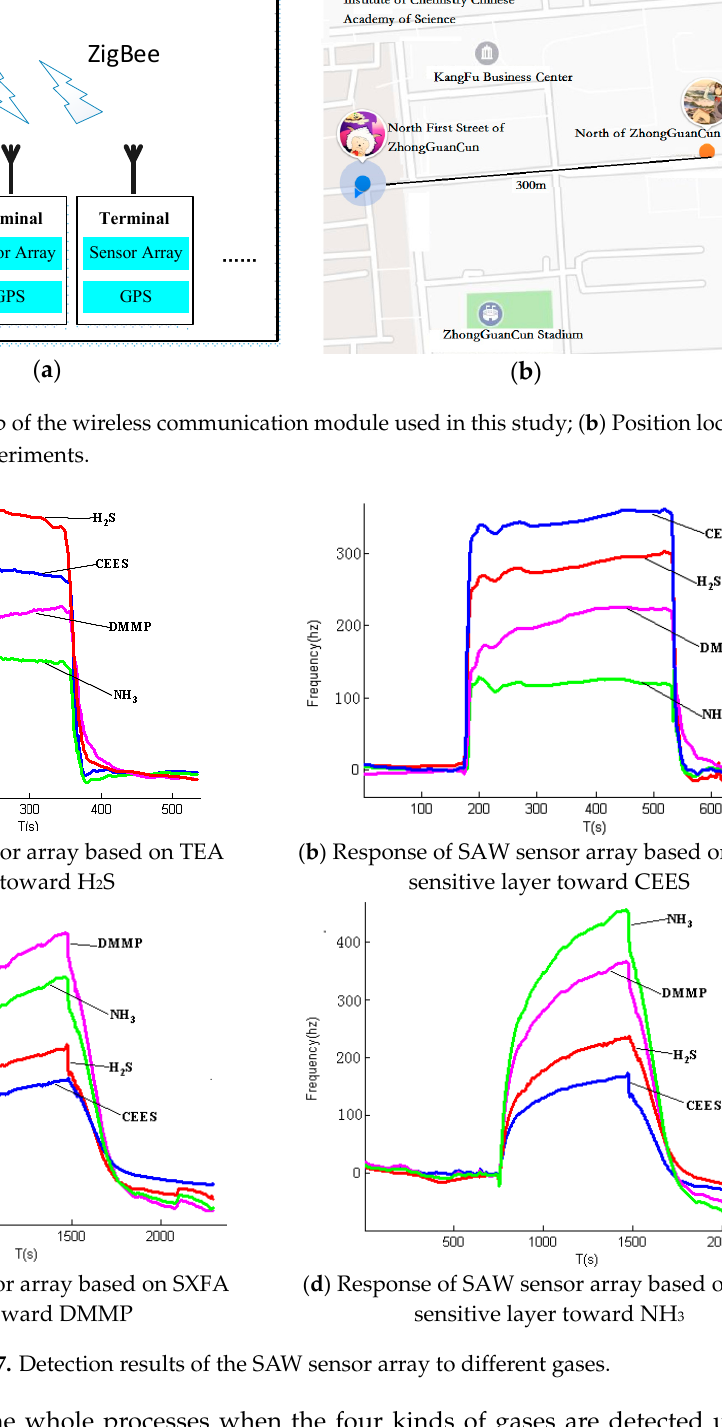
Figure 7. Detection results of the SAW sensor array to different gases.